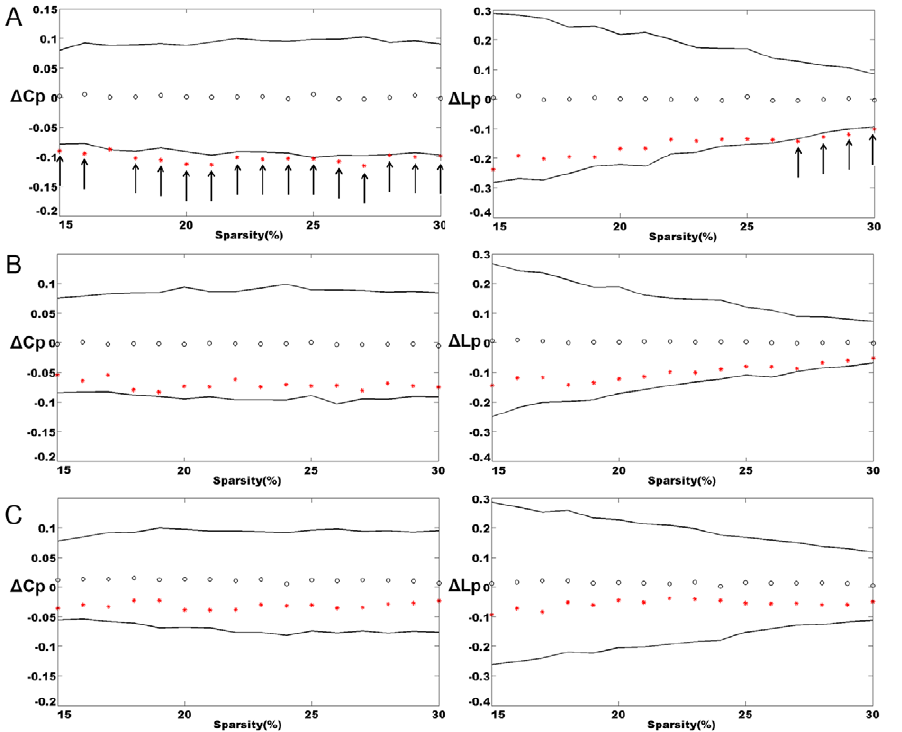
Figure 4. Between-group differences in the clustering coefficient (C p ) and the absolute path length (L p ) over a range of sparsity values. The left shows the between-group differences in clustering coefficients ( D Cp) and the right shows the between-group differences in absolute path lengths ( D Lp) over a wide range of sparsity values ( 15% ƒ S ƒ 30% ). The black open circles represent the mean values and the black lines represent the 95% confidence intervals of the between-group differences obtained from 1000 permutation tests at each sparsity value. A - Differences between the NC and AD groups ( D Cp=Cp NC 2 Cp AD , D Lp=Lp NC 2 Lp AD ). B - Differences between the NC and MCI groups ( D